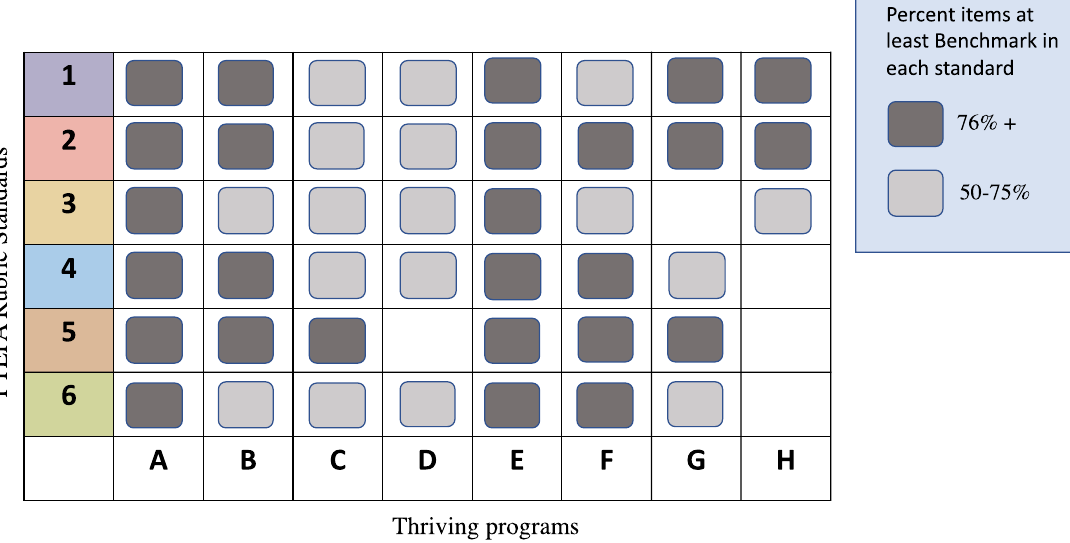
FIG. 1. Percent of ratings at least benchmark level at each studied program for each standard. Percentages are calculated by adding the percent benchmark and percent exemplary. Those for which 76% or more of items are rated at least benchmark are shaded dark gray; those for which 50% – 75% of items are rated at least benchmark are shaded light